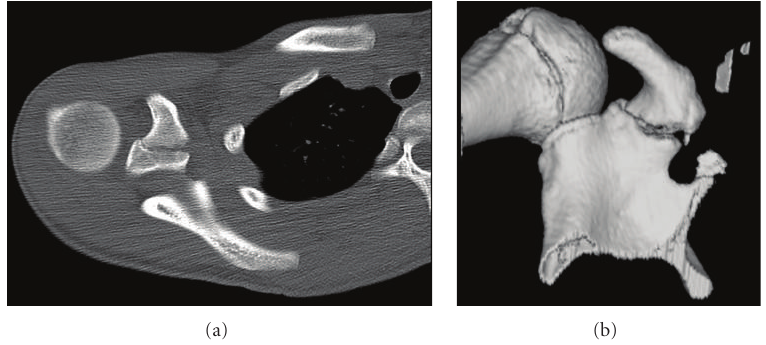
Figure 2: Case A: axial CT scan and CT 3D